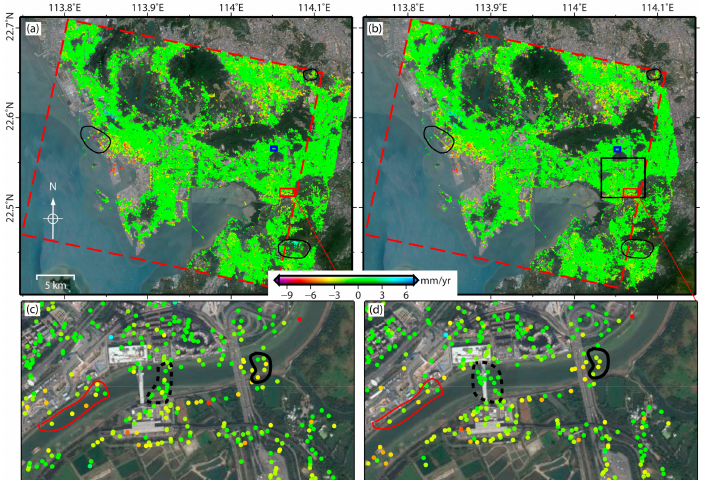
Figure 8. Mean deformation rate maps for C band with two external DEMs: SRTM-1arc DEM ( a ); and TanDEM-X DEM ( b ). The areas outlined by red dashed rectangles in ( a , b ) are the overlap area selected to compare the PS selection in ( a , b ). The black solid lines outline areas with obvious deformation rate differences between ( a ) and ( b ). ( c , d ) The amplification maps of the red solid rectangles in ( a , b ). The dashed black lines and solid red lines in ( c , d ) outline the area with obvious geocoding difference while the solid black lines in ( c , d ) represent the wrongly selected PSs The blue bold rectangles are the reference